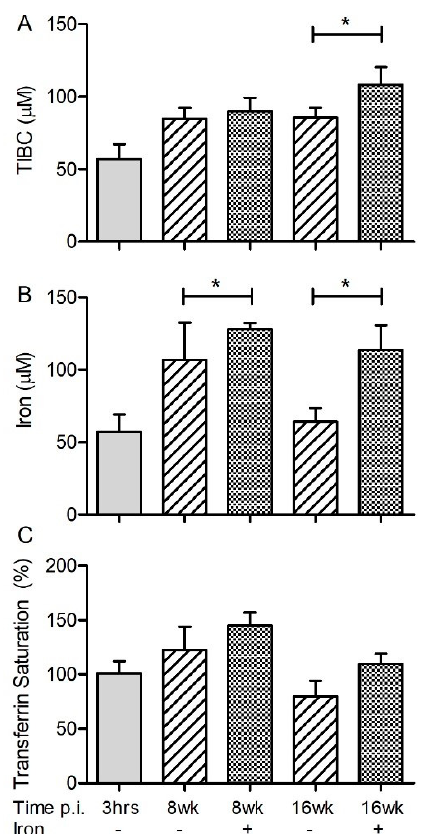
Figure 2. E ff ect of Fe-supplementation on the lung iron parameters of rabbits at 8 and 16 weeks post infection. TIBC (top; A ), total iron (middle; B ) and percent transferrin saturation (bottom; C ) were determined in the homogenates of Mtb-infected and placebo (-) or Fe ( + ) treated rabbits. Data was analyzed by one-way Anova with Tukey’s multiple comparison test. Values plotted are mean +/ – sd with n = 4 per group per time point. * p < 0.05.